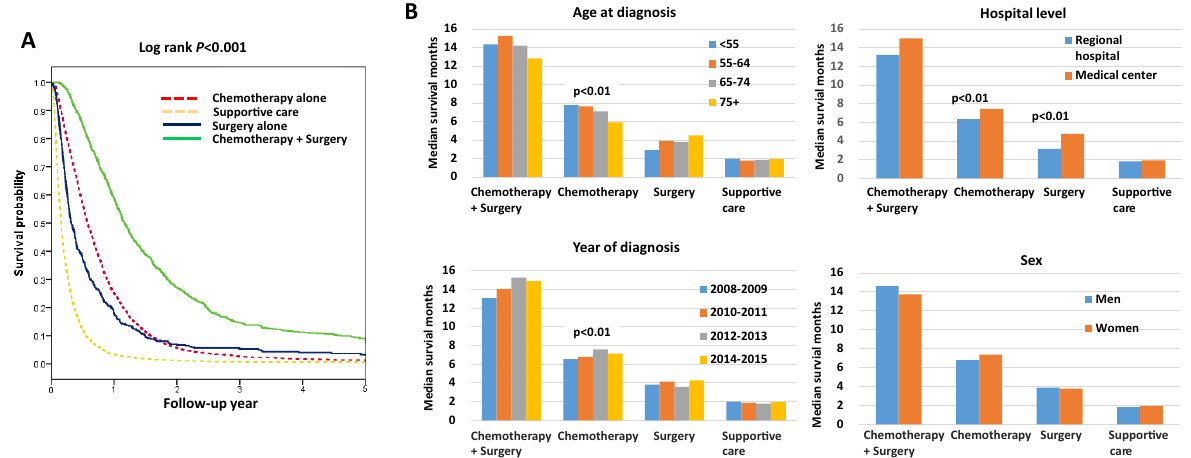
Figure 2. The survival analysis of metastatic gastric adenocarcinoma patients in Taiwan. ( A ) The overall survival curve of metastatic gastric adenocarcinoma patients by treatment modality. ( B ) The subgroup analysis of overall survival for age at diagnosis, year of diagnoses, sex, and treatment hospital level by treatment modality in metastatic gastric adenocarcinoma